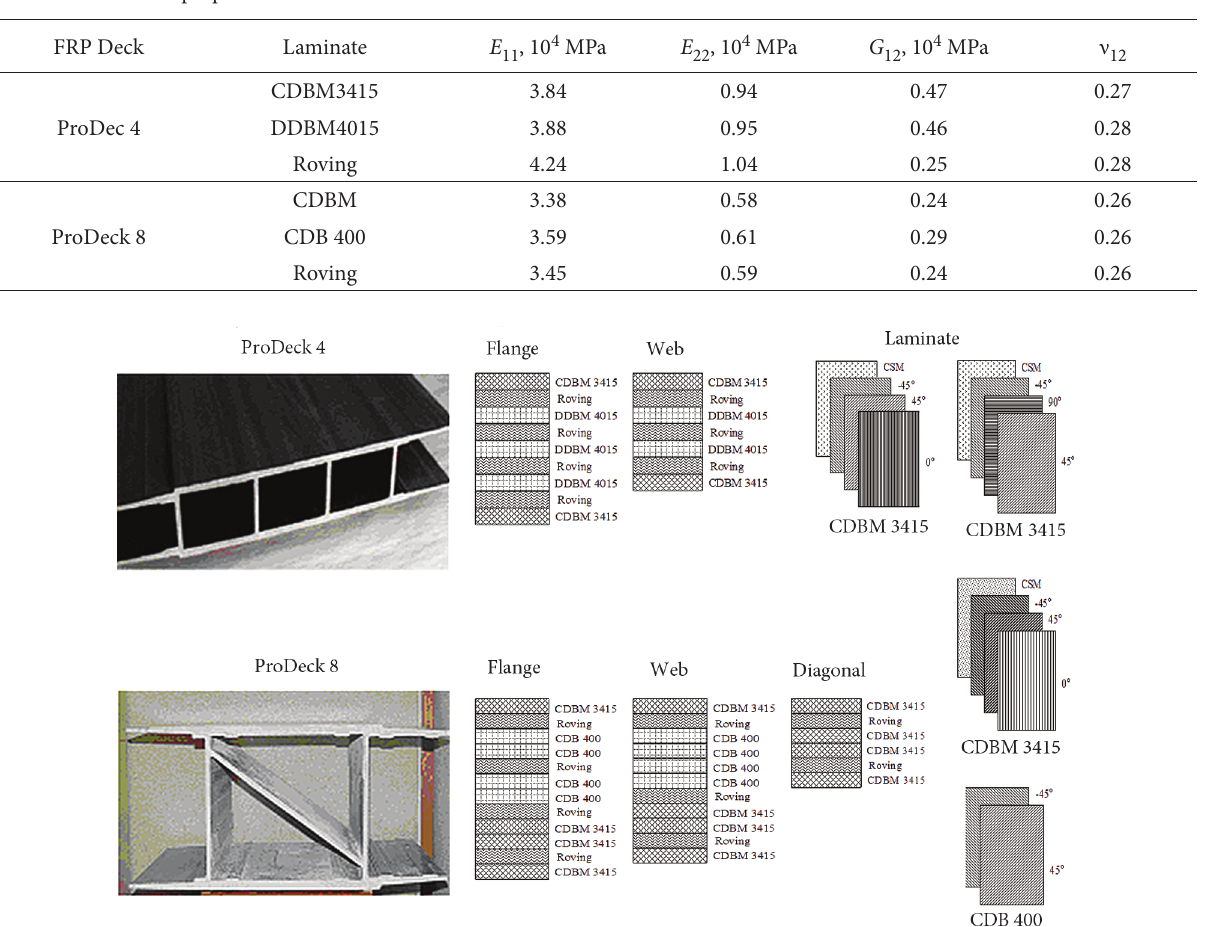
Fig. 1. Layer construction and laminate stacking